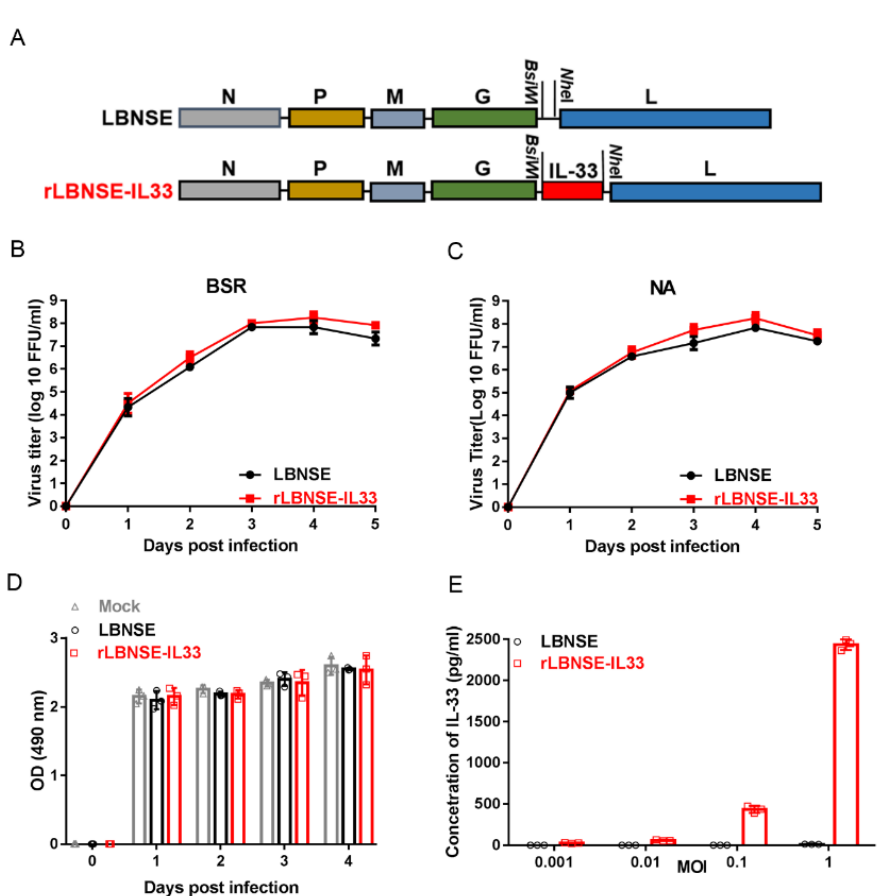
Figure 1. Construction and characterization of rLBNSE-IL33 in vitro: ( A ) schematic representation for LBNSE and rLBNSE-IL33 construction. The parent vector pLBNSE was derived from SAD-B19 strain with long non-coding region between G and L genes deleted, and at the deletion region, restriction enzyme sites of BsiWI and NheI were introduced. RABV nucleoprotein, phosphoprotein, matrix, glycoprotein, and polymerase genes were represented by N, P, M, G, and L, respectively. Murine IL-33 was acquired and inserted in between G and L gene of RABV genome. Supernatants of LBNSE and rLBNSE-IL33 infected cells at the MOI of 0.01 were collected to determine the titers of LBNSE and rLBNSE-33 at 1, 2, 3, 4 and 5 dpi; ( B , C ) virus multiple-step growth curve in BSR cells and NA cells respectively; ( D ) viability of BSR cells at 1, 2, 3 and 4 dpi. ( E ) IL-33 expression level in the infected cells by ELISA. Error bars indicated standard deviation (SD, n =